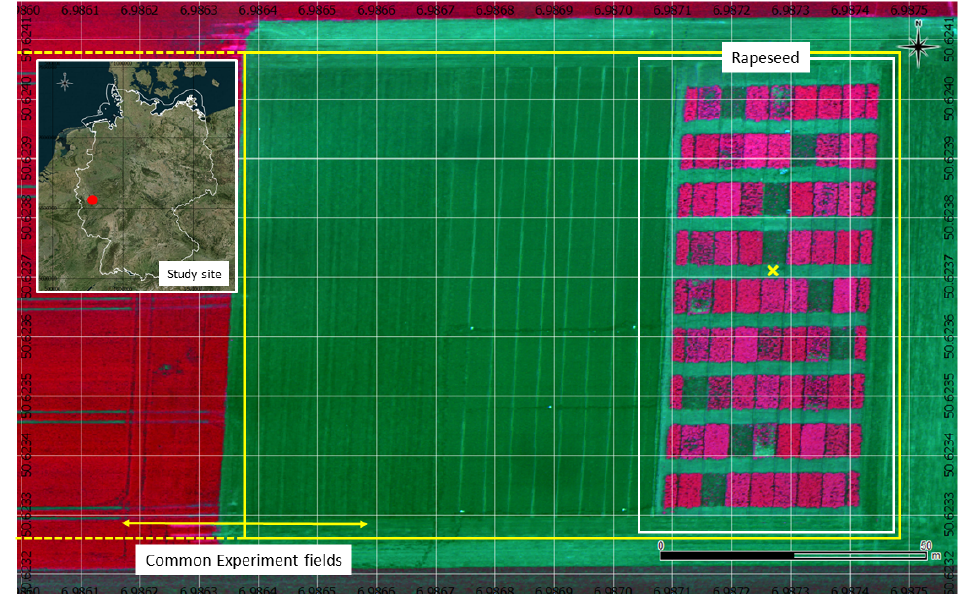
Figure 2. VNIR-generated colour infrared (CIR) map (NIR-red-green composite) of the rapeseed experiment (white border) as part of the Common Experiment (yellow border) with bare soil patches, at recording time (11 April 2018, 13:42 CET), prepared for maize and summer wheat experiments. The Common Experiment follows crop rotation with homogeneously planted crops; in this image, summer barley (dotted yellow margin) is planted every two years. Furthermore, south of the Common Experiment, sugar beet and, to the north, barley were grown, according to standard agricultural practice. A data logger was placed within the rapeseed field (yellow x; 50.6237N, 6.9873E). The spatial resolution of the CIR map is 7 cm per